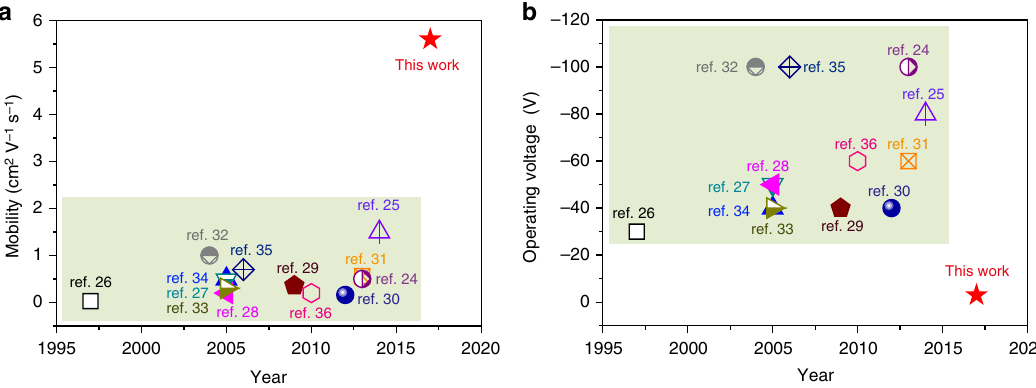
Fig. 6 Comparison of device performances of this work and references. The distribution of mobility ( a ) and operating voltage ( b ) of OTFTs based on polyimide as dielectrics in the ref. 24 – 36 and this